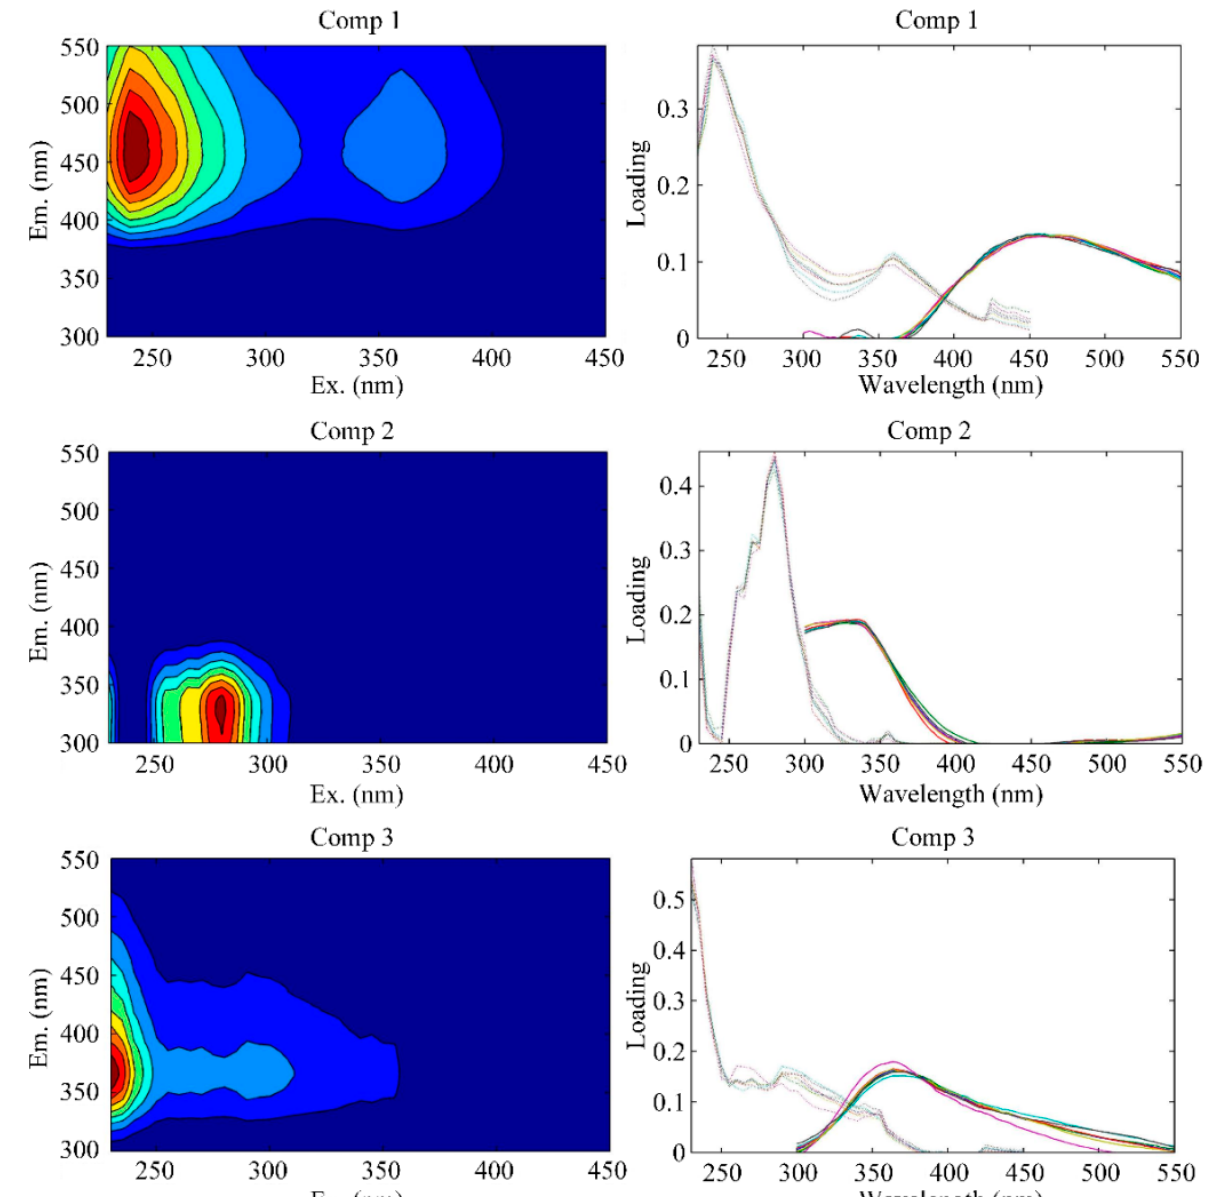
Figure 8. Excitation–emission matrix fluorescence spectroscopy (EEMS) contour plots and loadings of each component determined using parallel factor analysis (PARAFAC). Three fluorescence components, including the humic-like component (Comp1), the protein-like component (Comp2), and the protein-like component (Comp3), were extracted using PARAFAC. Table 2. Characteristics of the chromophoric dissolved organic matter (CDOM) components de- termined using the parallel factor analysis (PARAFAC) model in this study and comparison with the results of previous studies.